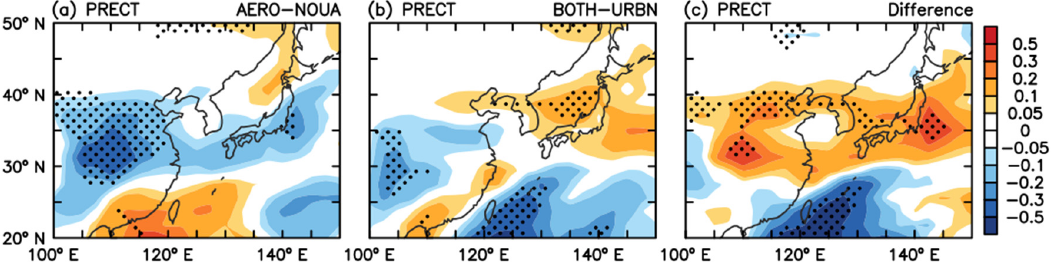
Figure 11. Same as in Figure 5, but for total precipitation (in mm/day) over East Asia from ( a ) AERO − NOUA; ( b ) BOTH − URBN; and ( c ) their difference (i.e., ( b ) minus ( a )).